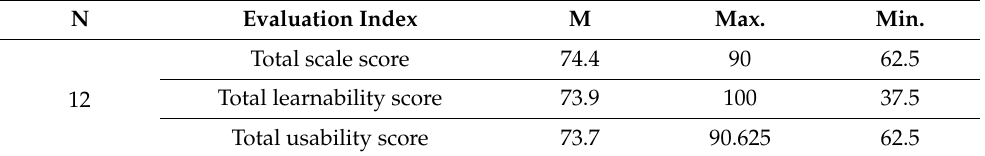
Table 5. Evaluation and test results of the interactive app using System Usability Scale